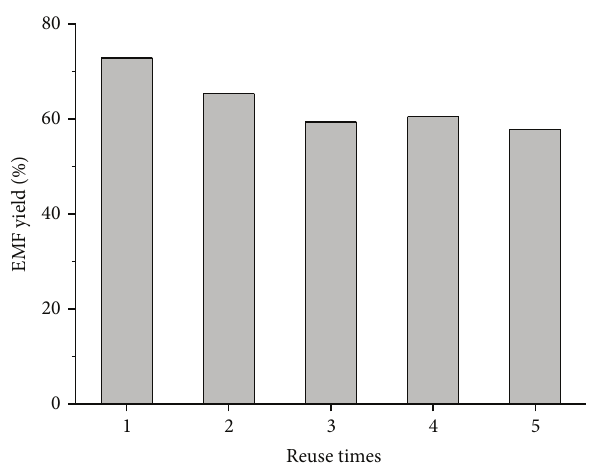
Figure 7: Recycle experiments for catalytic transformation of fructose into EMF with the catalyst poly(VMPS)-PW at 110 ∘ C for